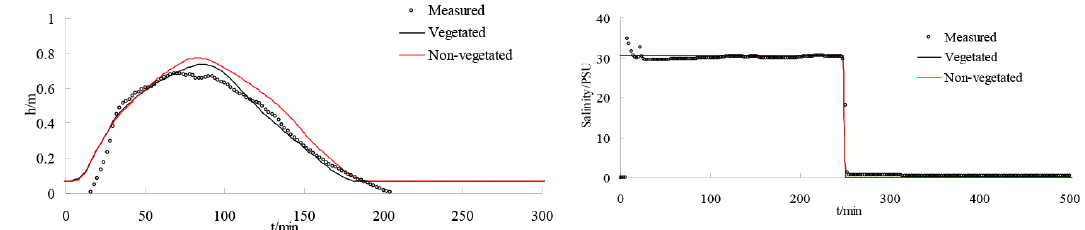
Figure 17. Comparison of water depth and salinity in vegetated and non-vegetated areas at location